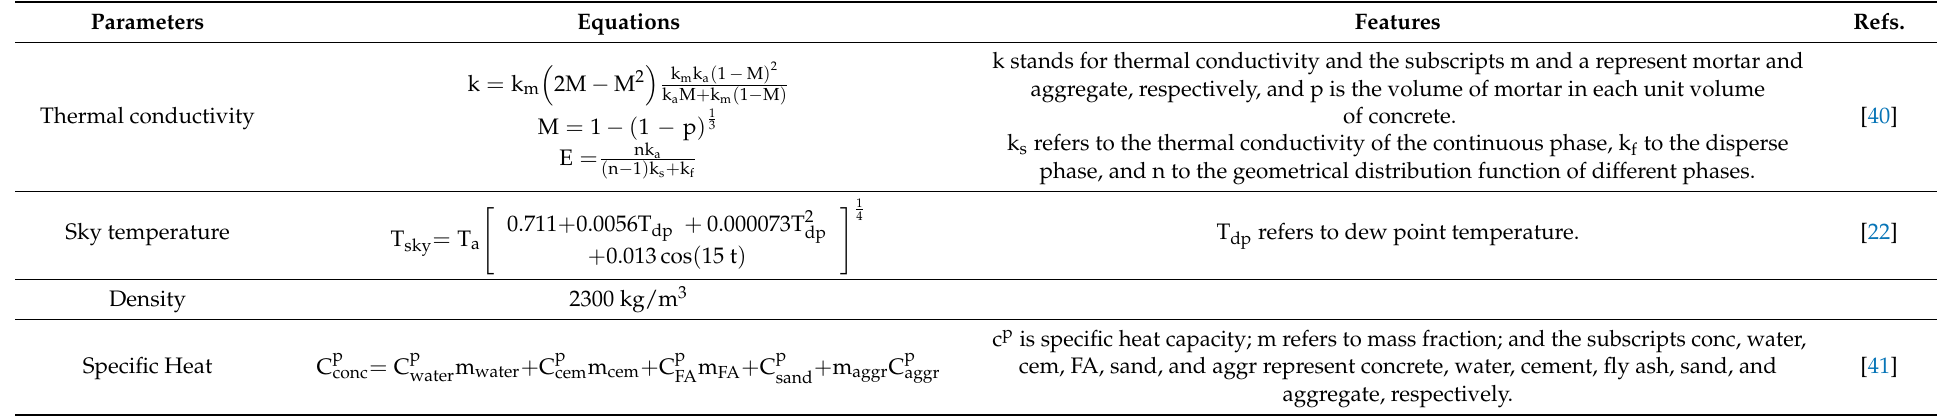
Table 2. Parameters of the concrete and boundary